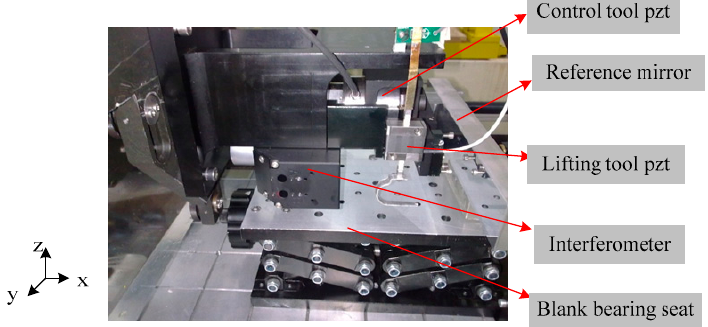
Figure 13. Structural Diagram of the active tool control system.